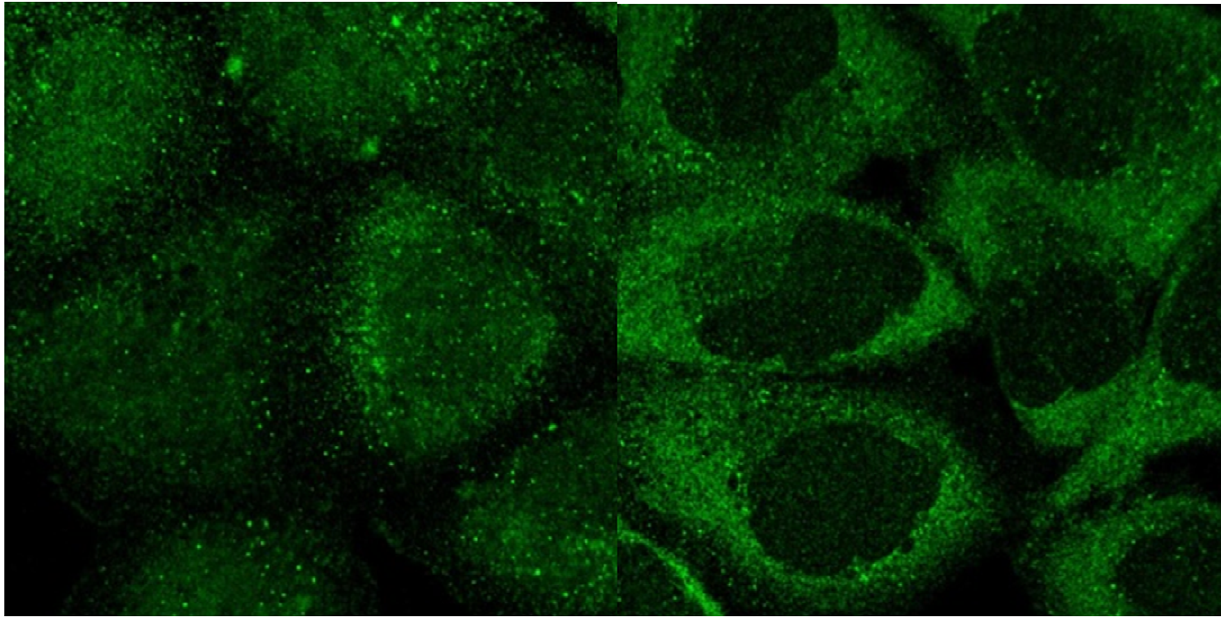
Figure 5. Example of sub-patterns identified by clustering. Proteins ‘‘neuronal pentraxin receptor’’ and ‘‘eukaryotic translation initiation factor 5 0 were visually annotated as ‘‘cytoplasm,’’ but hierarchical clustering assigned them to separate clusters in the first round. The images indicate that they indeed display two cytoplasmic sub-patterns.